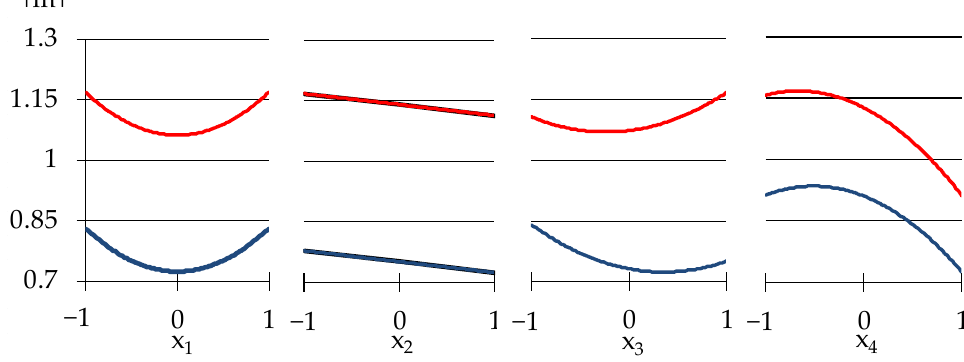
Figure 5. The influence of composition factors on the rate of structural destruction.